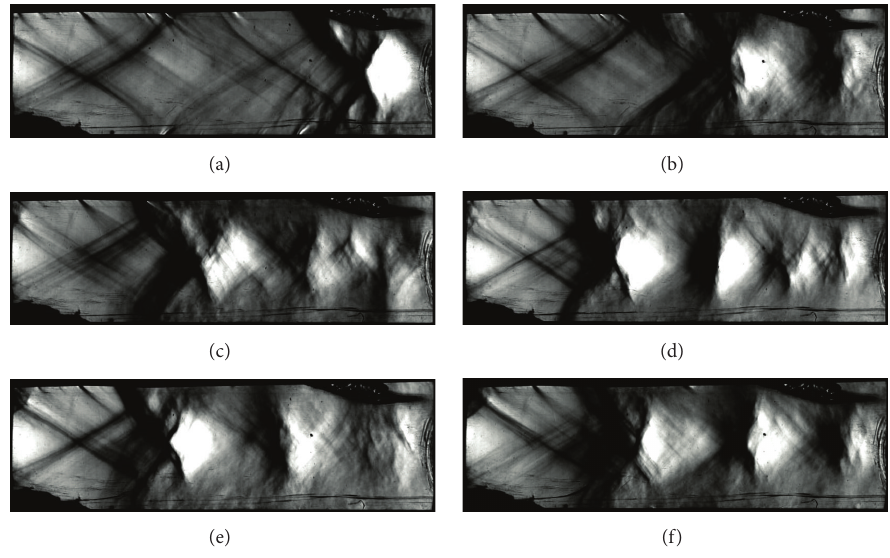
Figure 14: Schlieren graphs of the expansion region with air throttling at the location of 875 mm from the entrance of the combustor at different times (a ∼